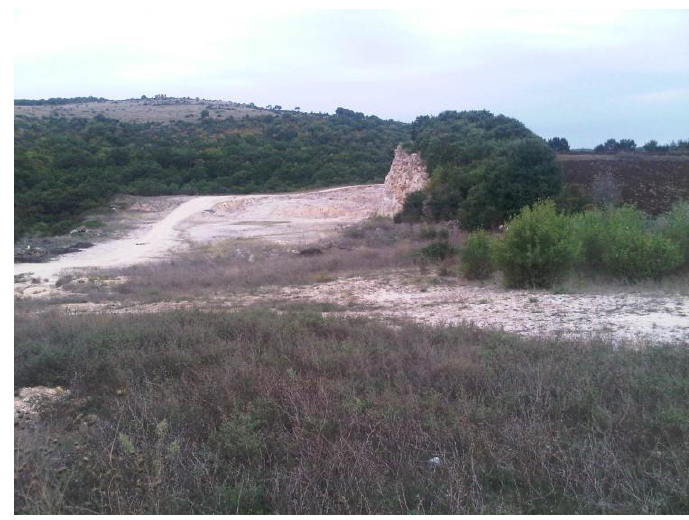
Figure 3. Area of the quarry, vertical face of 18–20 m next to existing agricultural land.